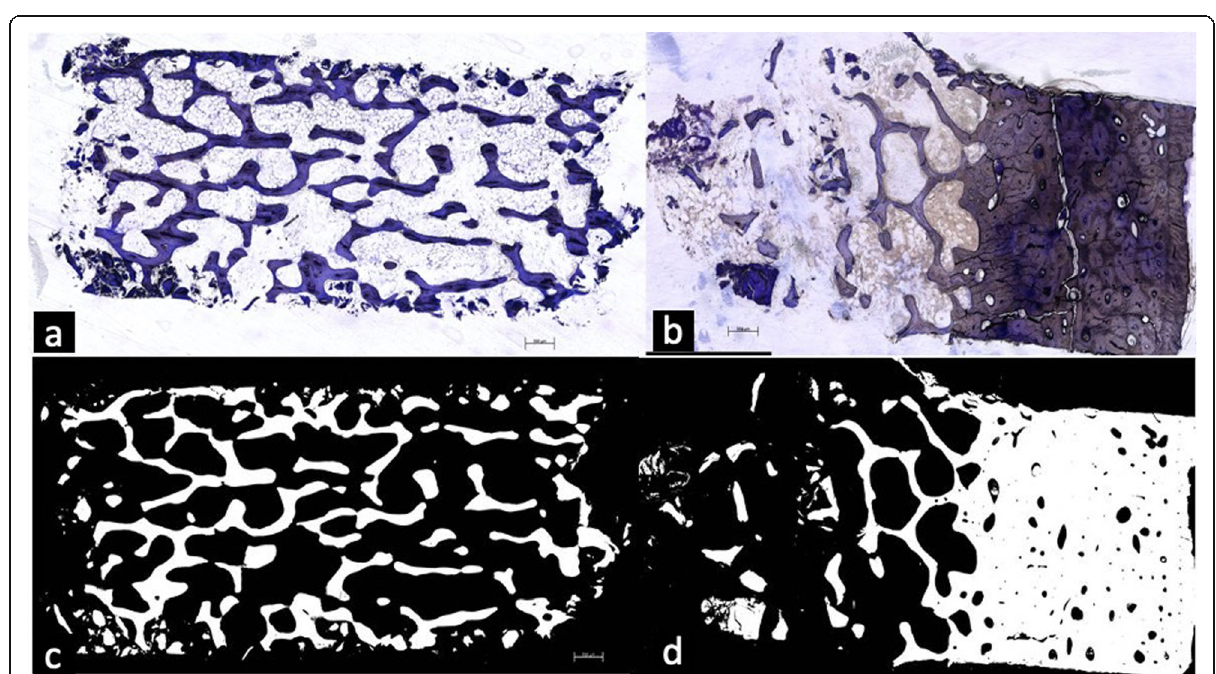
Fig. 2 The height of the bone cortex was measured on samples stained with toluidine blue ( a , b ) and later by micro-radiography ( c , d ). a The study group. b The control group with the bone cortex. c The study group. d The control group with cortical